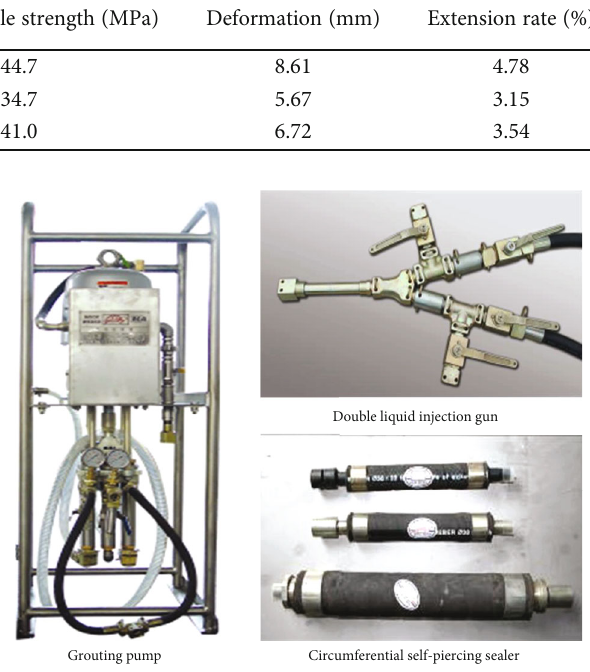
Figure 19: Grouting